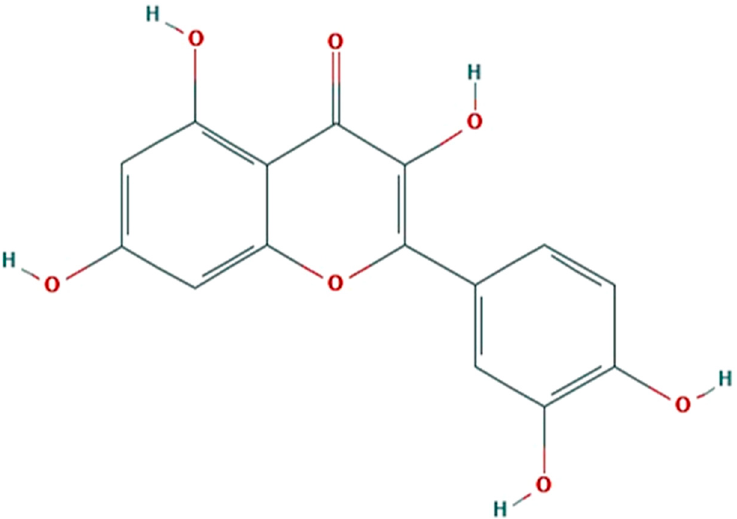
Figure 1. Molecular structure of quercetin (C 15 H 10 O 7 ). (Source: https://pubchem.ncbi.nlm.nih.gov).